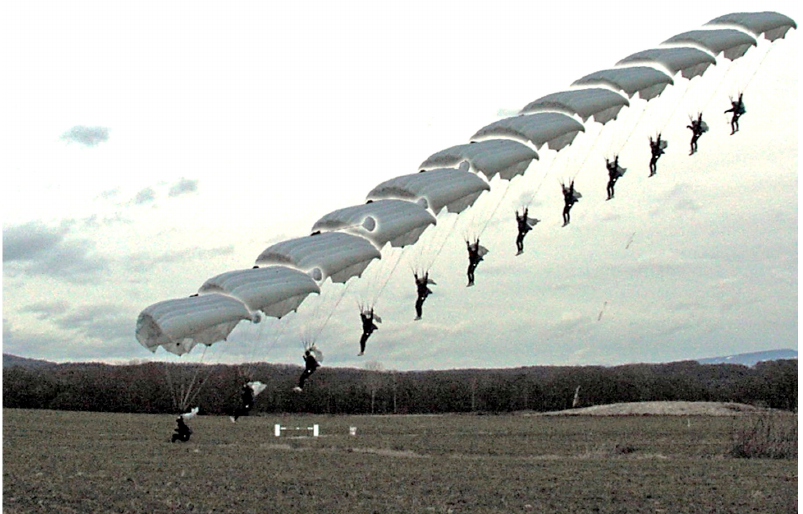
Figure 13. Landing with parachute M-282 near reference length (source: The authors of this article).